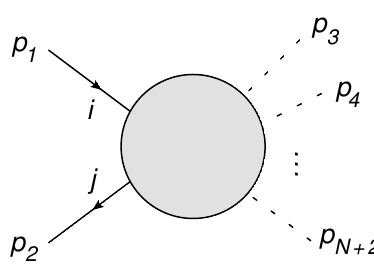
Figure 3 . The amplitude for the production of N colour-singlet particles from a quark-antiquark pair, without (cid:12)nal state QCD